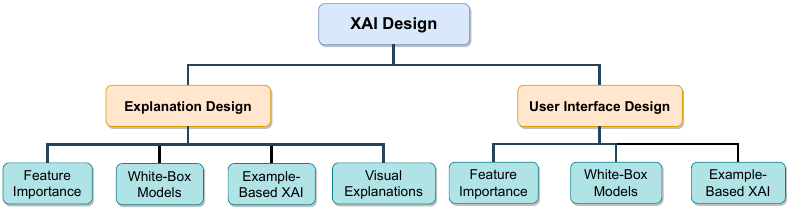
Figure 5. Classification of the reported XAI design